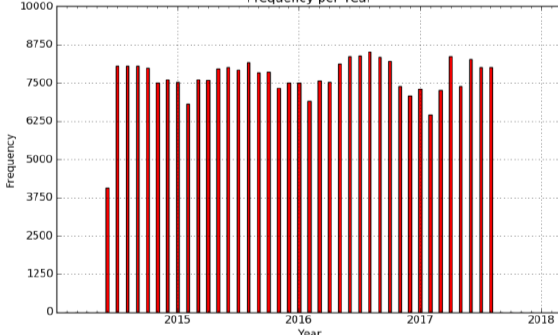
Figure 4. The location of the police station and crime data